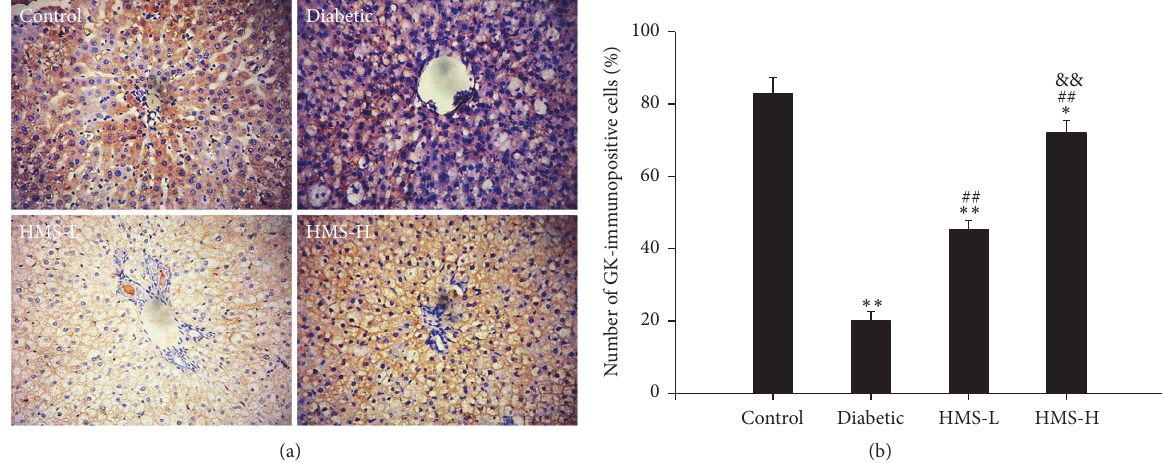
Figure 4: Effects of HMS5552 on GK immunoreactivity in the rat liver. Liver tissue sections stained with anti-GK antibody are shown at 200x magnification (a), and the number of GK-immunopositive cells was analyzed (b). HMS-L group, low-dose (10mg/kg) HMS5552-treated diabetic group; HMS-H group, high-dose (30mg/kg) HMS5552-treated diabetic group. The data are expressed as the mean ± SD ( 𝑛 = 6 ). ∗ 𝑃 < 0.05 and ∗∗ 𝑃 < 0.01 , compared with the control group; ## 𝑃 < 0.01 , compared with the diabetic group; && 𝑃 < 0.01 , compared with the HMS-L group.